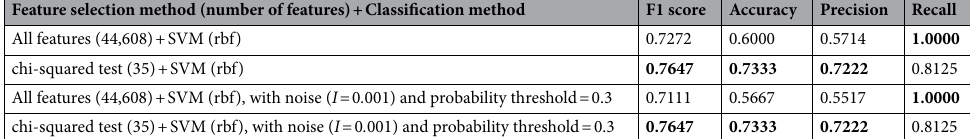
Table 2. The results on different methods with transcriptome data only. The first method trained the model on the original training set without feature selection. The second method performed feature selection by chi-squared test and selected 35 features. For the last two methods, they are similar with the first two methods respectively while the only difference was that they added the noise and changed the probability threshold. The random seed of the noise was 21, which was the best result on this intensity ( I = 0 .